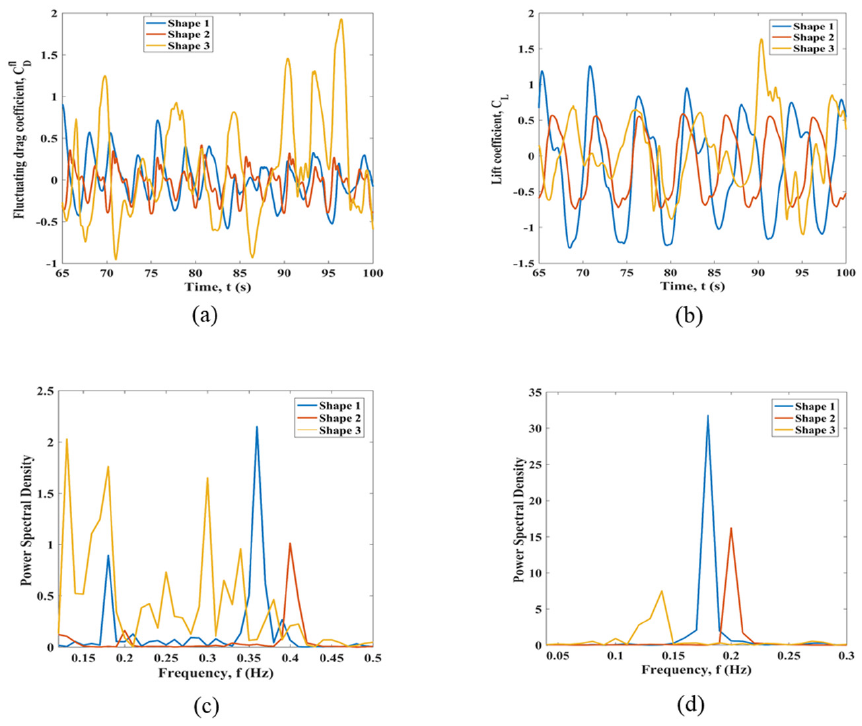
Figure A19. Fluid force coefficients for cylinder 5 immersed in planar sheared flow: ( a ) time history of the fluctuating drag coefficient; ( b ) time history of the lift coefficient; ( c ) the fluctuating drag co–efficient FFT; ( d ) the lift coefficient FFT.